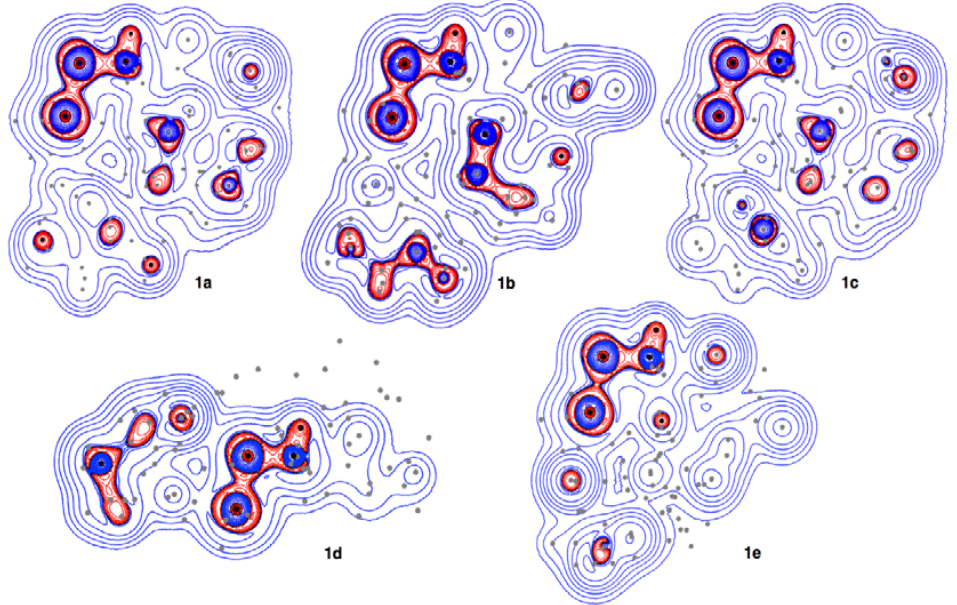
Figure 8. Negative Laplacians drawn on the SSC planes of 1a – 1e . The negative areas are shown in red and the positive areas are in blue.